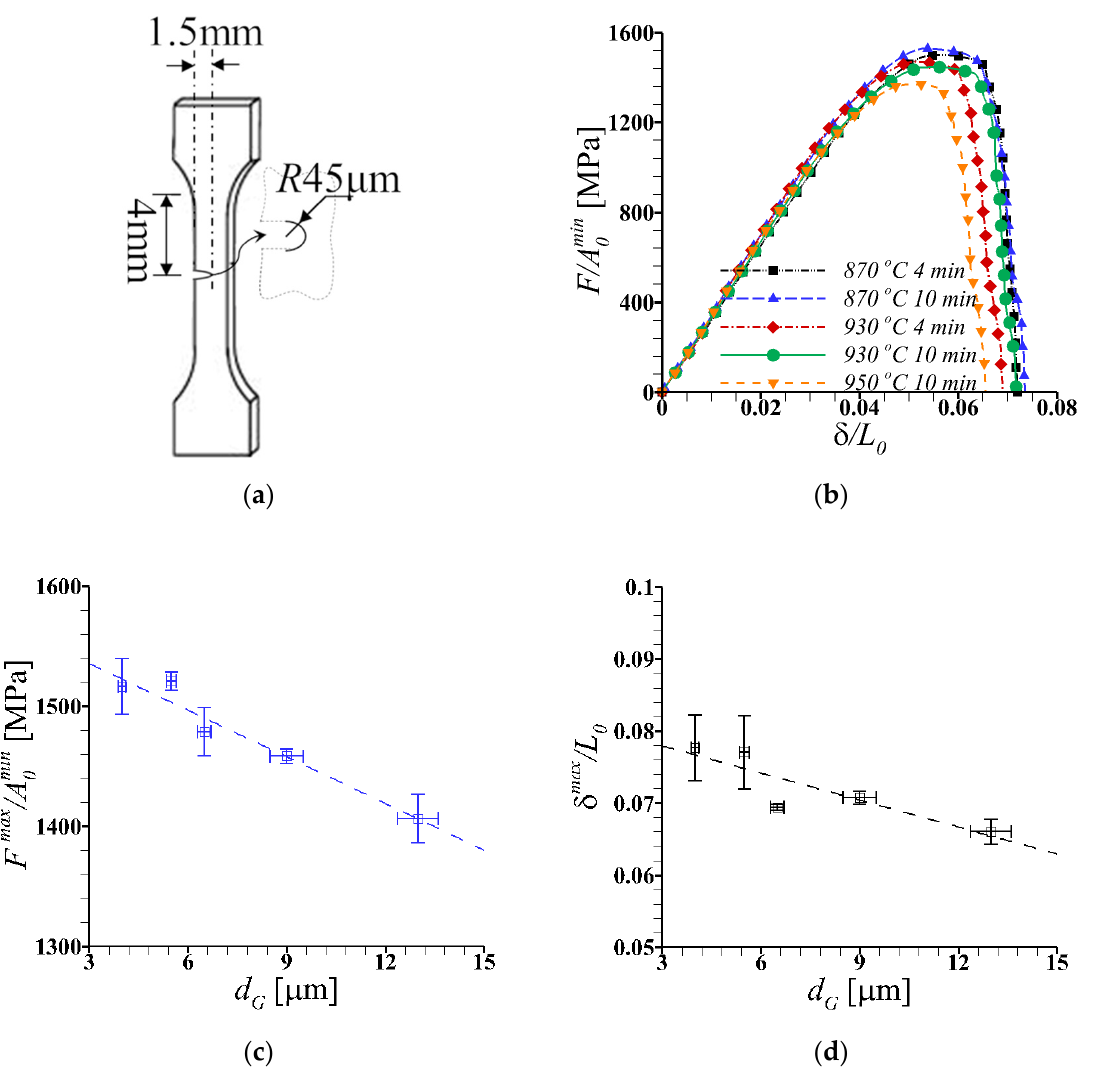
Figure 5. ( a ) Schematic of the single-edge notch specimen. ( b ) Normalized force-extension curves (force, F , is normalized by the minimum cross-sectional area, A min , and extension, δ , is normalized by the initial gauge length, L 0 ) of the five heat-treated martensitic steel. ( c ) Variation in the normalized maximum force, F max / A min , and that of the ( d ) normalized maximum extension, δ max / L 0 , with average prior austenite grain size, d G